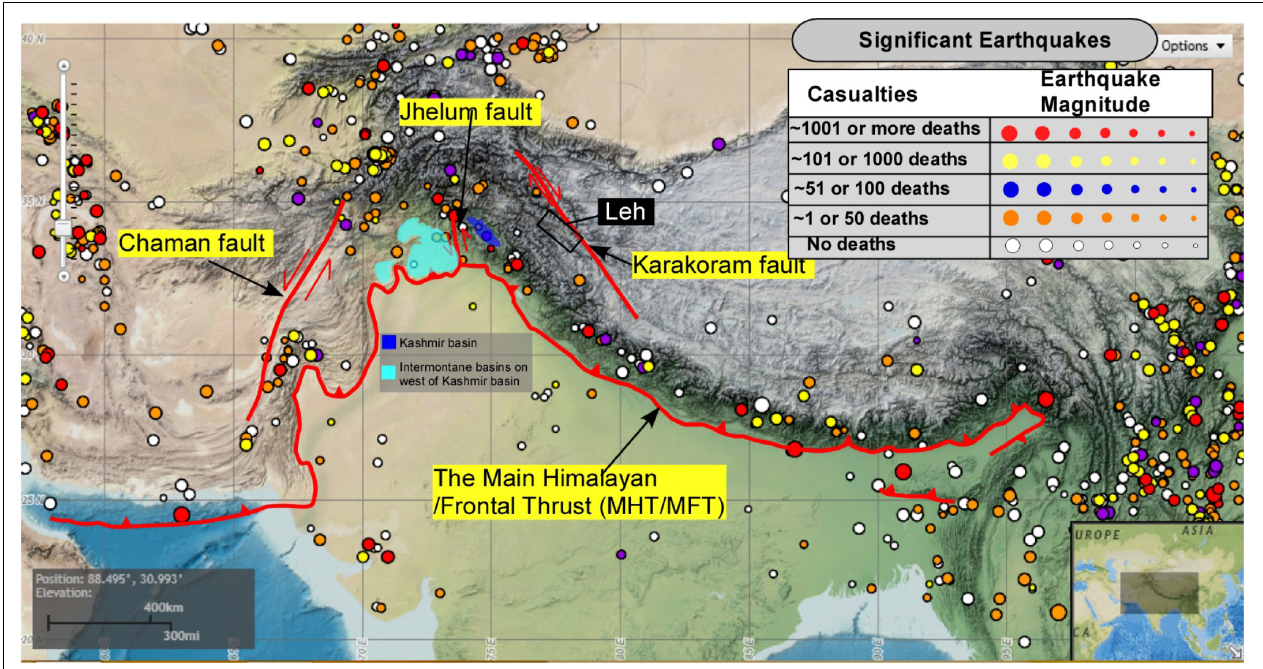
FIGURE 1 | Shows the distribution of significant earthquakes (as colored dots) and the associated casualties (color indicates the number of deaths) on the satellite image of the Himalayas. The Leh and Kashmir basin are shown as colored polygons. The major active faults are highlighted in red lines. The figure is prepared from the freely available data on NOAA’s Natural Hazard Viewer. It is retrieved on 20th July 2018 from NOAA National Centers for Environmental Information at: https://maps.ngdc.noaa.gov/viewers/hazards/?layers=2&extent=-180,70,180,-70.